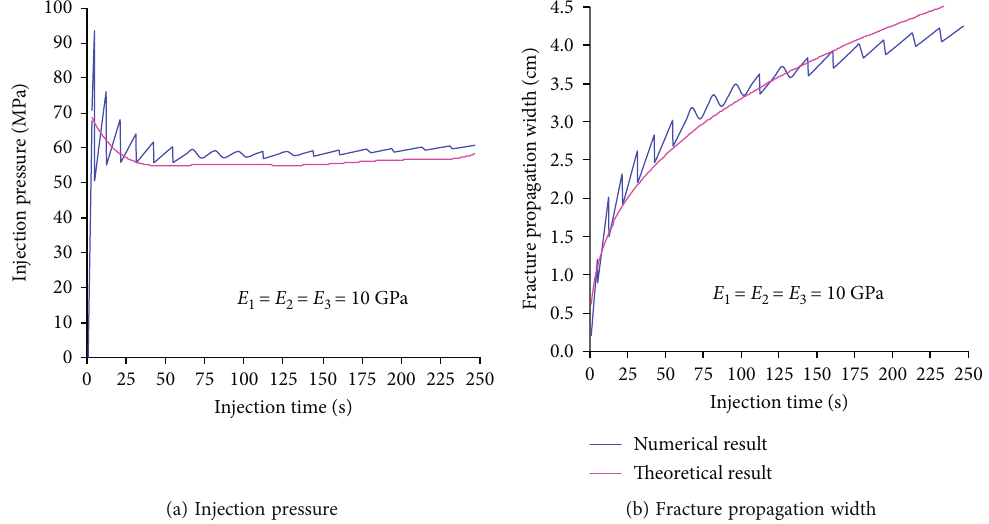
Figure 5: Injection pressure and fracture propagation width vs. injection time at the injection